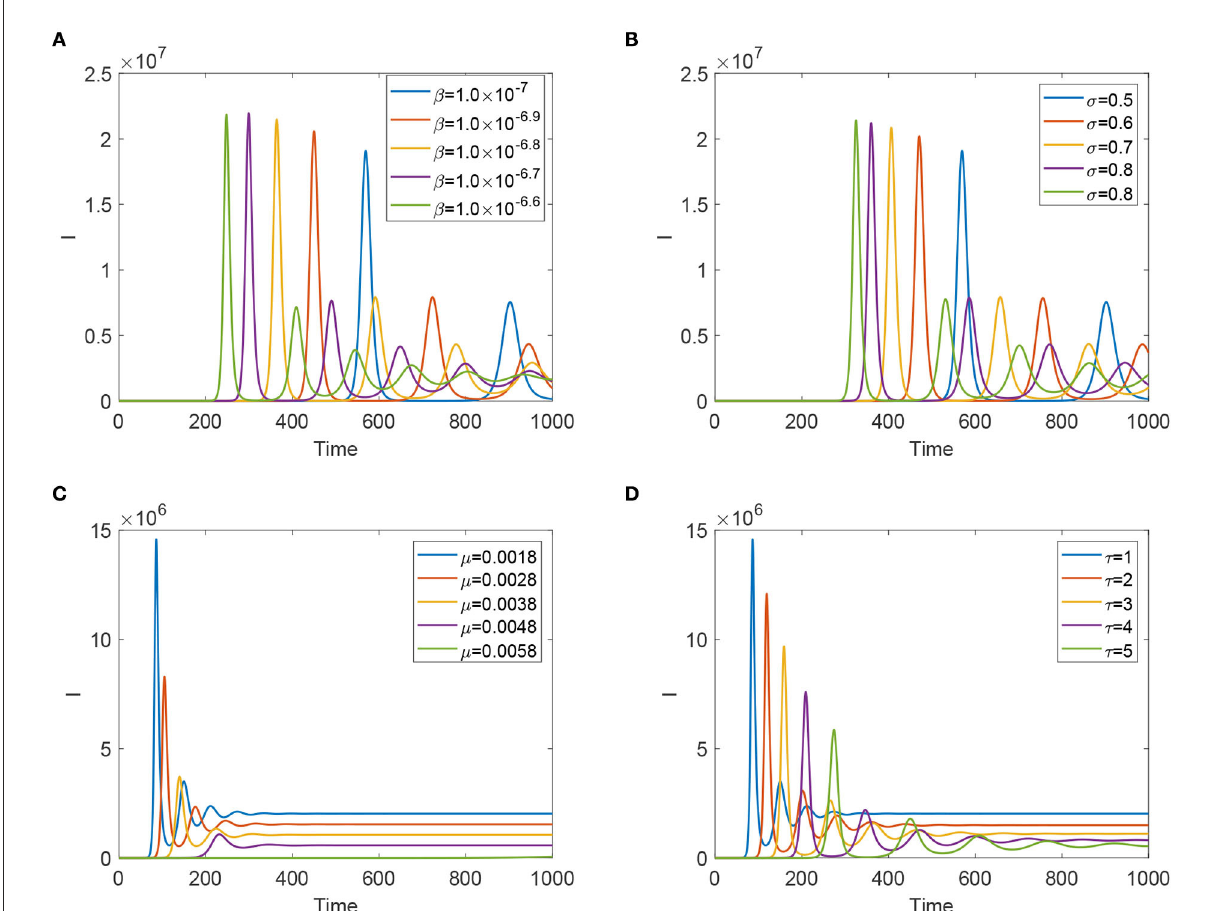
FIGURE4 Evolution of infected animals and FMD virus with some significant parameters. (A) With different β . (B) With different σ . (C) With different µ . (D) With different τ